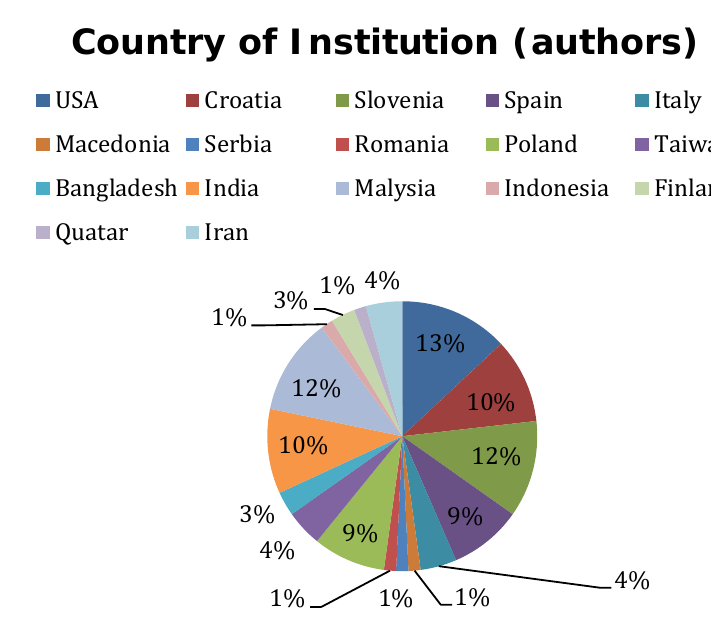
Figure 1. Country of Institution. Source: